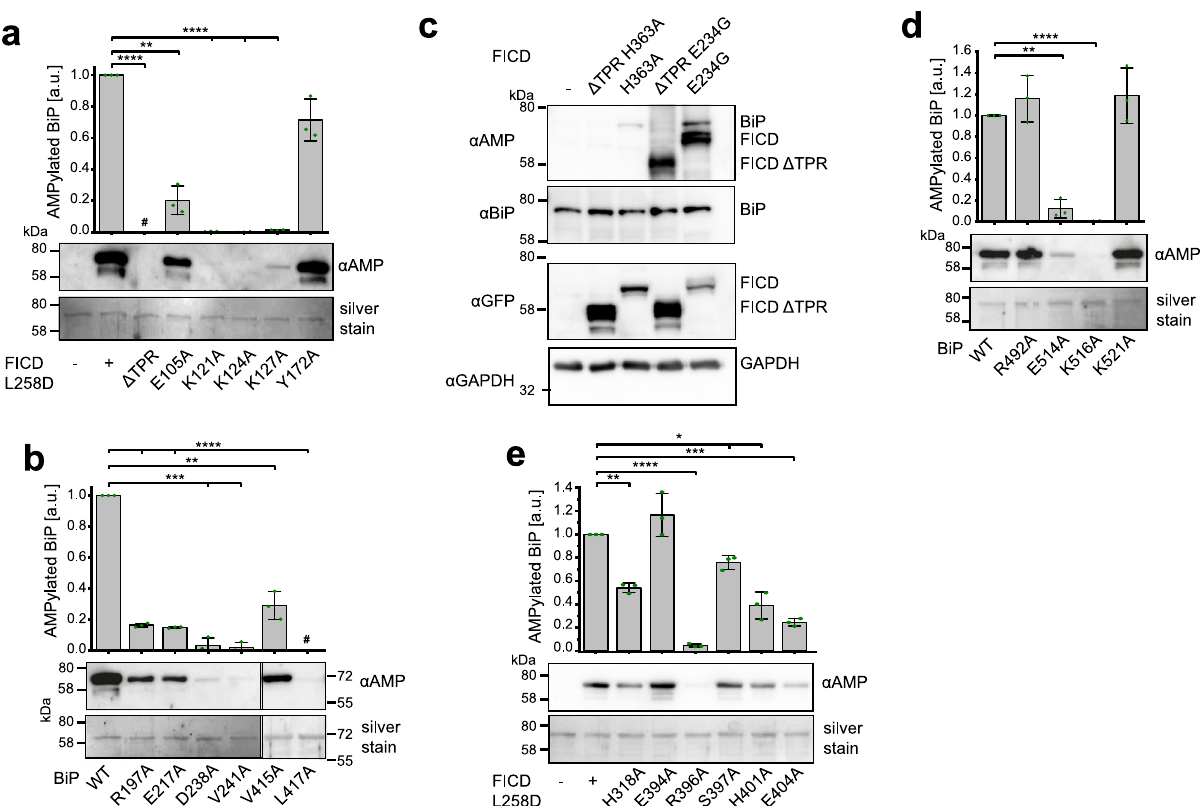
Fig. 3 Con fi rmation of the TPR – NBD interface of the FICD TReND -BiP complex and biochemical elucidation of Fic domain – SBD interaction. a AMPylation of BiP 19 – 654 WT by FICD 102 – 458 L258D bearing distinct alanine substitutions within the TPR motif. The reaction was stopped after 30 min and the extent of AMPylation quanti fi ed via western blot with an α AMP-antibody. The experiment was performed in three independent replicates. Data are presented as mean values + / − standard deviation. Compared to FICD L258D, the p values of Δ TPR, E105A, K121A, K124A, K127A, and Y172A are <0.0001, 0.0044, <0.0001, <0.0001, <0.0001, and 0.0661, respectively. b FICD 102 – 458 L258D mediated AMPylation of BiP 19 – 654 bearing single-point mutations within the NBD. Experimental set-up as in a . The experiment was performed in three independent replicates. Data are presented as mean values + / − standard deviation. Compared to BiP WT, the p values of R197A, E217A, D238A, V241A, V415A, and L417A are <0.0001, <0.0001, 0.0008, 0.0003, 0.0053, and <0.0001, respectively. c Validation of the contribution of the TPR motif to BiP AMPylation in HEK293 cells. The lysates of HEK293 cells overexpressing different constructs of GFP-tagged FICD with (102 – 458) or without TPR motifs ( Δ TPR: 187 – 458) were analyzed via western blotting. GFP was detected to verify expression, whereas GAPDH detection served as a loading control. Representative blots are shown from three biological replicates. d FICD 102 – 458 L258D mediated AMPylation of BiP 19 – 654 bearing single-point mutations within the SBD. Experimental conditions as in a . The experiment was performed in three independent replicates. Data are presented as mean values + / − standard deviation. Compared to BiP WT, the p values of R492A, E514A, K516A, and K521A are 0.3374, 0.0033, <0.0001, and 0.3407, respectively. e AMPylation of BiP 19 – 654 WT by FICD 102 – 458 L258D bearing distinct alanine substitutions within the Fic domain. Experimental conditions as in a . The experiment was performed in three independent replicates. Data are presented as mean values + / − standard deviation. Compared to FICD L258D, the p values of H318A, E394A, R396A, S397A, H401A, and E404A are 0.0028, 0.2580, <0.0001, 0.0197, 0.0119, and 0.0006, respectively. The number sign (#) indicates missing values due to inactivity. The signi fi cance in a , b , d , and e was determined via paired two-tailed t test: * p < 0.05, ** p < 0.01, *** p < 0.001, and **** p < 0.0001. a.u. arbitrary units. Source data are provided as a Source data fi